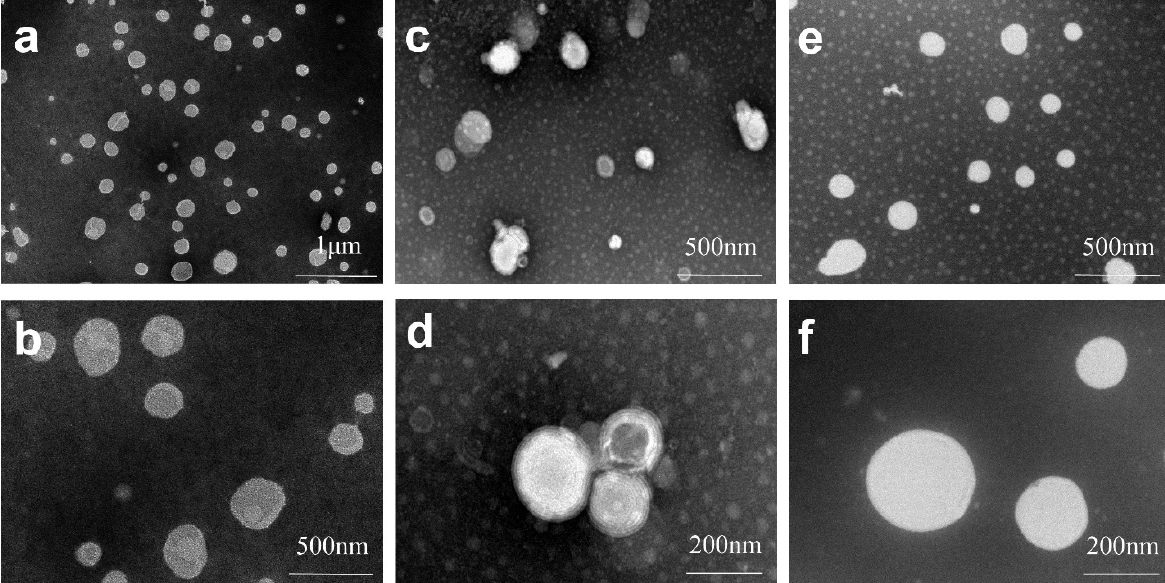
Figure 3. Transmission electron microscopy (TEM) images of BVP-NS ( a , b ), BVP-LP( c , d ) and BVP-PLC (1:2) ( e , f ).